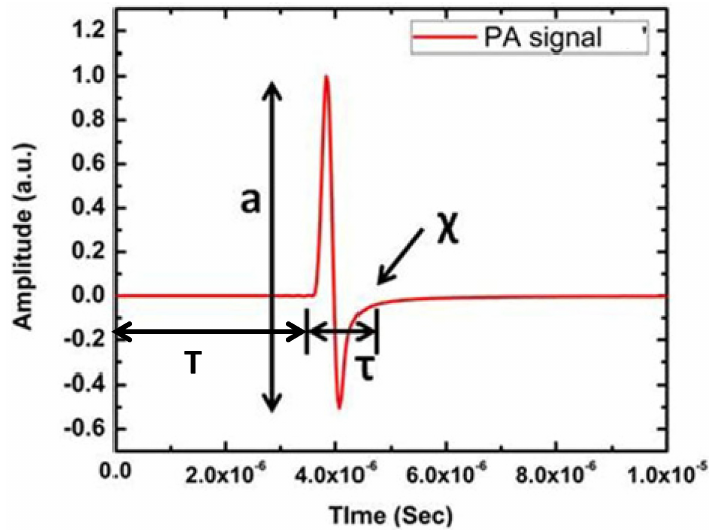
Figure 2. A typical PA signal from circular numerical target where a is amplitude, T is time of flight, τ is width and χ is the relaxation time of the PA time domain